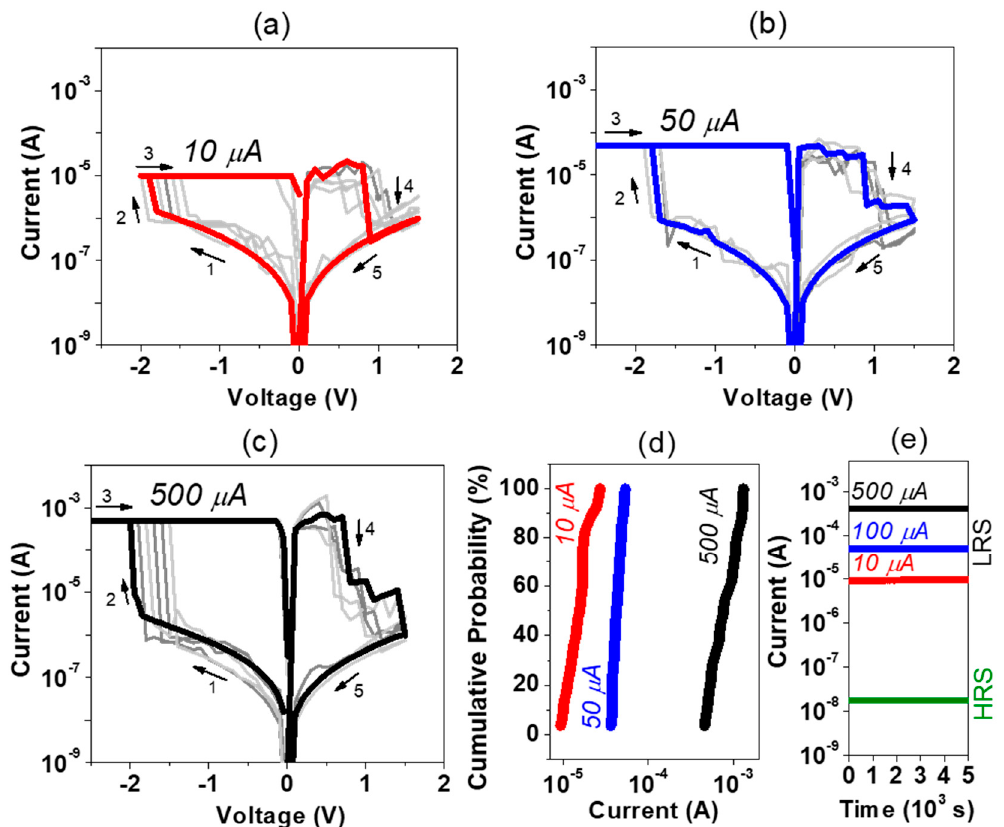
Figure 4 . Typical I–V cycles of devices formed at CCs of 10 µA ( a ), 50 µA ( b ), and 500 µA ( c ), respectively, corresponding distribution of low resistance states (LRS) states ( d ) and retention over 5 × 10 3 s ( e ).